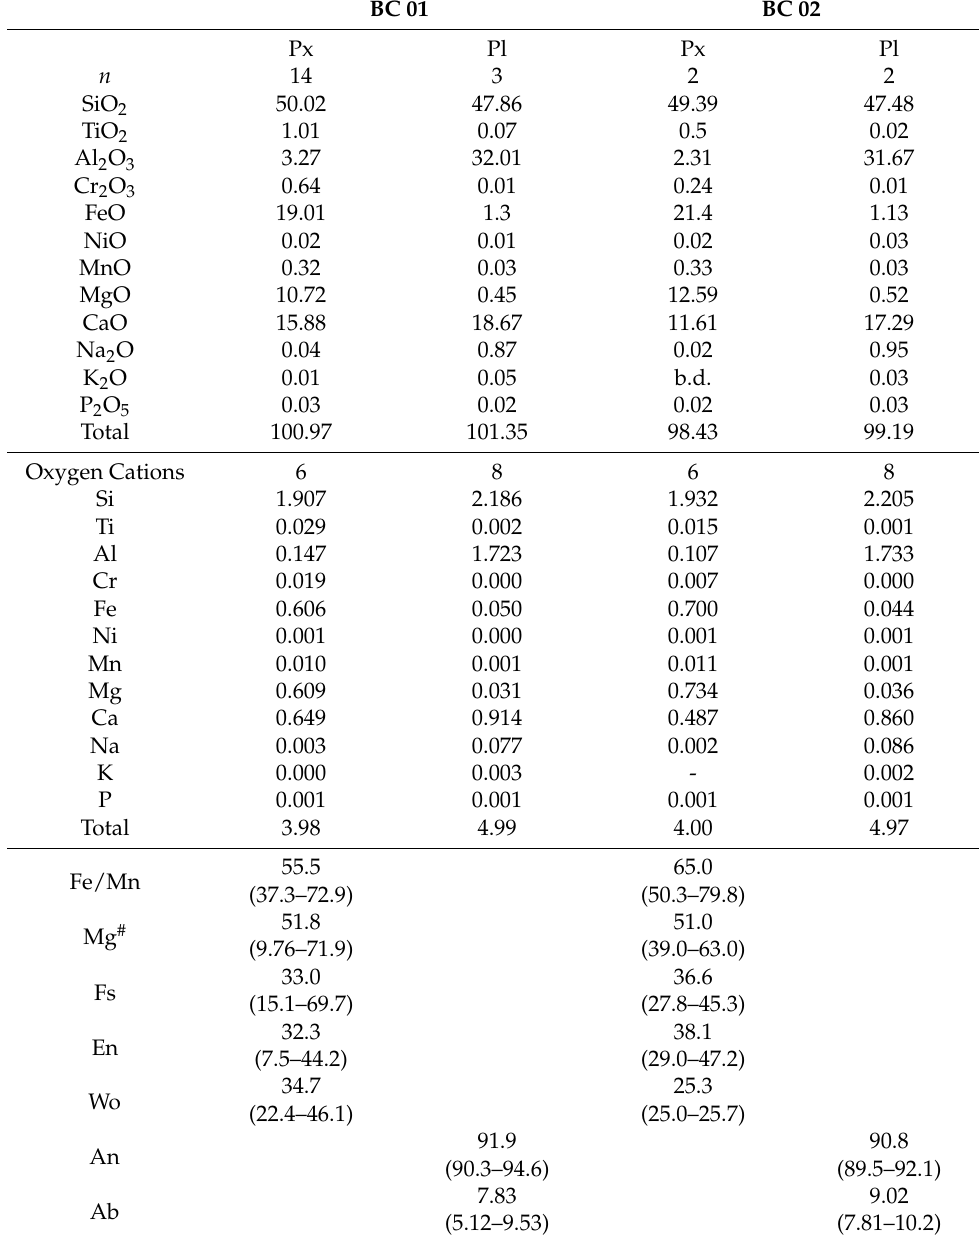
Table 3. Compositions of pyroxenes (Px) and plagioclases (Pl) in basaltic